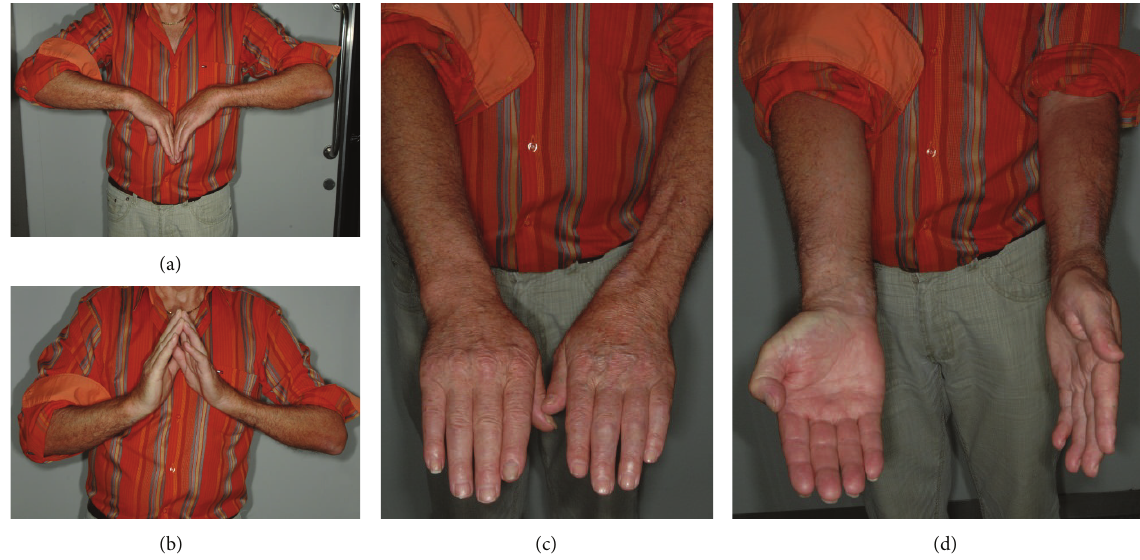
Figure 3: (a–d). Postoperative functional result 18months after allograft implantation in the left distal radius after resection of an osteosarcoma in a 64-year-old